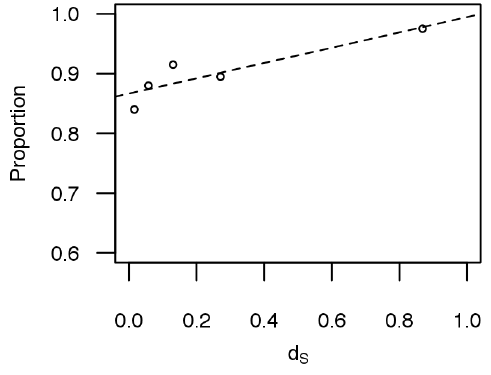
Figure 2. The relationship between proportion of duplicate gene pairs with different exon-intron structure and sequence divergence. Synonymous divergence is used to represent sequence divergence. Each point represents 200 gene pairs.